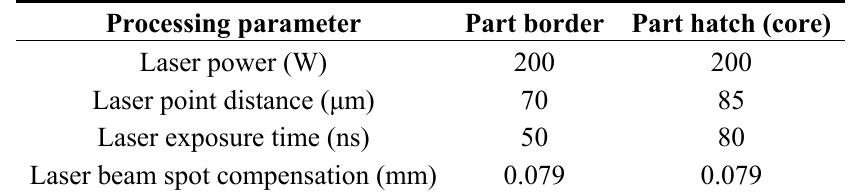
Table 1. Processing parameters used for specimen fabrication on the EOSINT M270. Processing parameter Part border